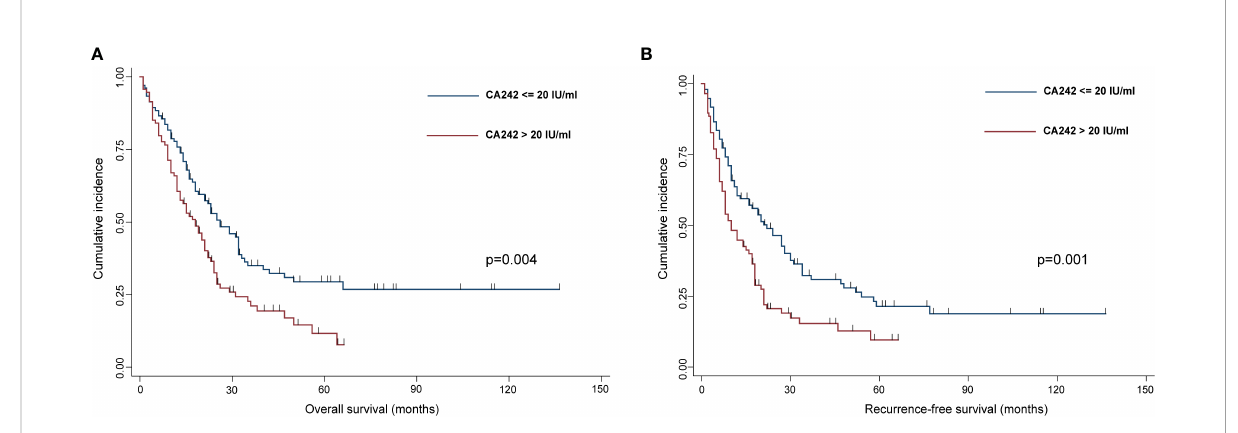
FIGURE 3 The Kaplan-Meier curves indicated the OS (A) and RFS (B) in HCCA